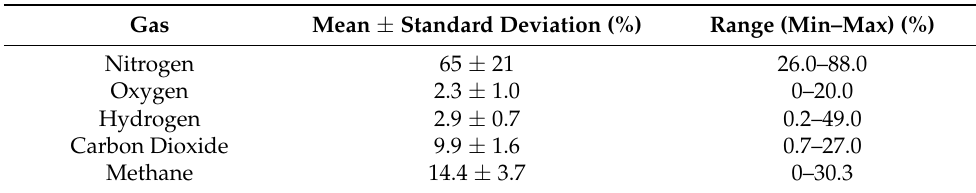
Table 1. Previously reported concentration ranges in flatus